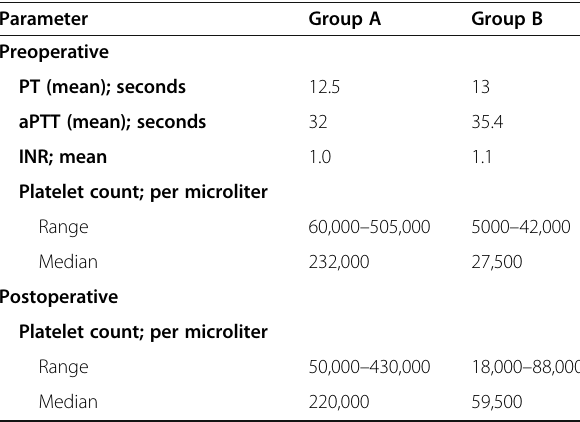
Table 2 The comparison between both groups regarding platelet levels and coagulation